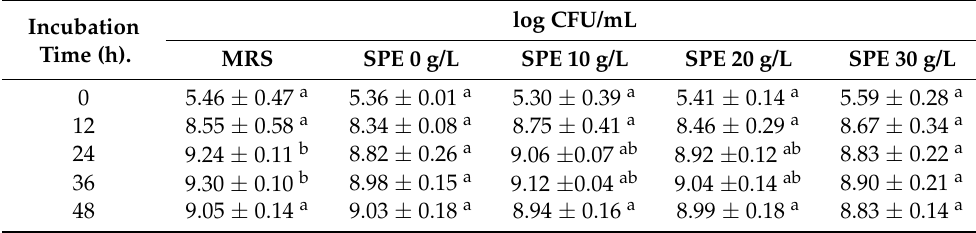
Table 1. Cell populations of Lpb. plantarum TISTR 2075 in MRS, sweet potato extract (SPE) mixed with 0, 10, 20, and 30 g/L of soybean powder media during 48 h of incubation. Incubation Time (h).